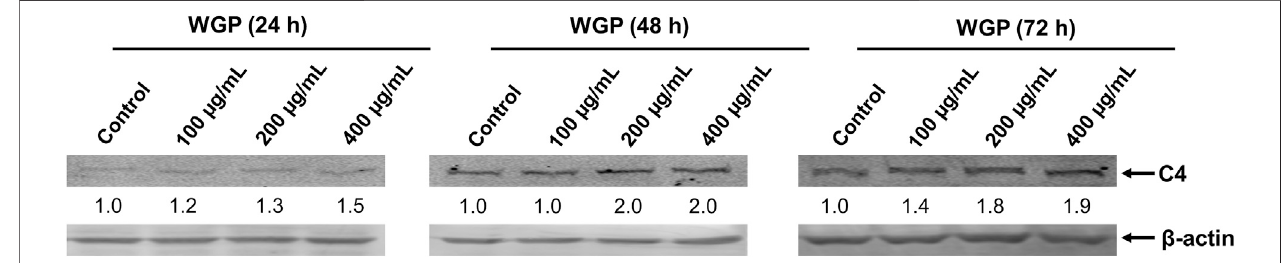
FIGURE 4 | WGP increase C4 production in hepatocytes. L-O2 cells were treated with WGP at a series of equal ratio gradient concentrations for 24, 48 or 72 h. Protein levels of C4 were determined using western blotting. The fold changes of C4 densitometry measurements were compared to β -actin and then normalized to the vehicle control.